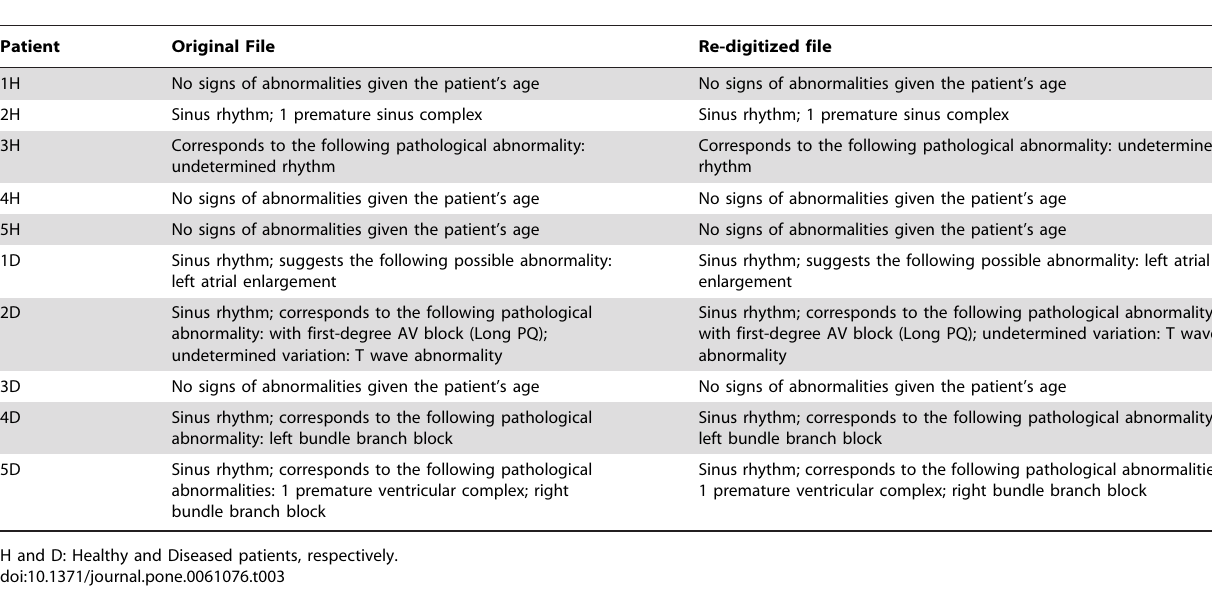
Table 3. Automated clinical diagnostic statements outputted by the Cardiax algorithm for the original versus re-digitized files when both files were collected on the same model of Cardiax ADC.